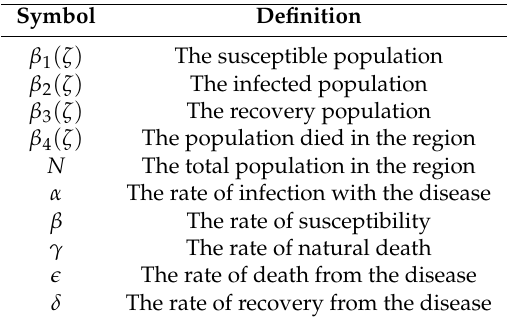
Table 1. Description of the independent variables and the involved